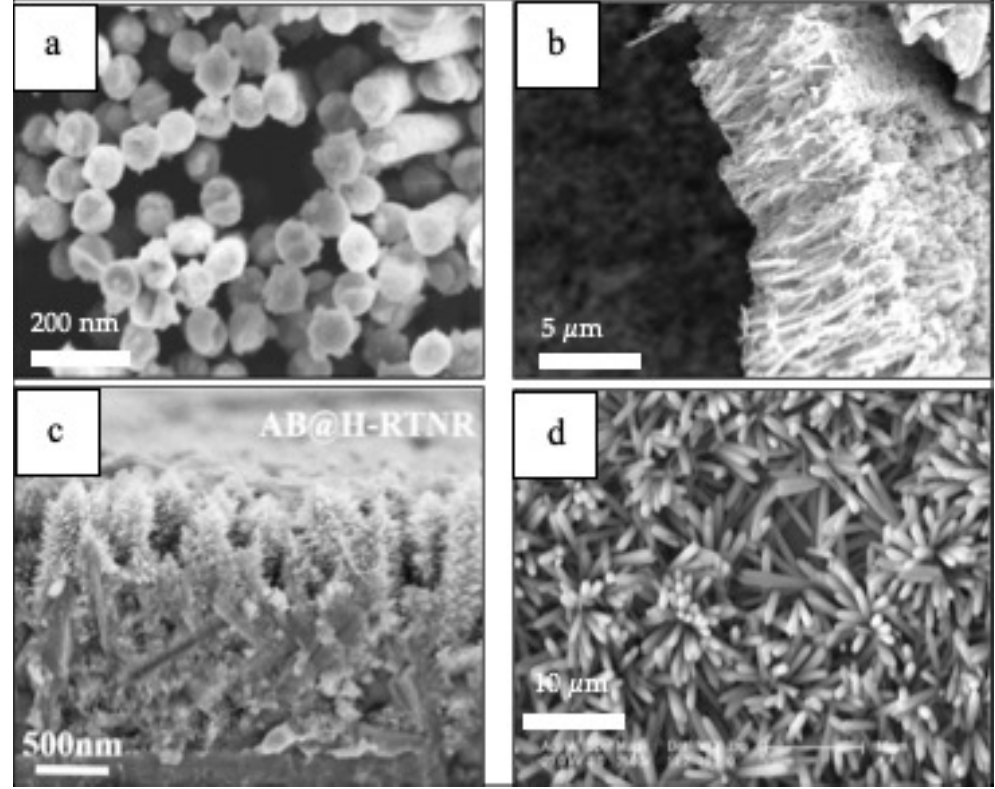
Figure 8. ( a ) Au–NiO 1 − x (0 < x < 1) hybrid nanowire arrays [106], ( b ) TiO 2 nanowires [107], ( c ) anatase-branch@hydrogenated rutile nanorod TiO 2 [108], ( d ) ZnO nanorods and MoS 2 flakes [109]. Reproduced with permission from references [106–109].